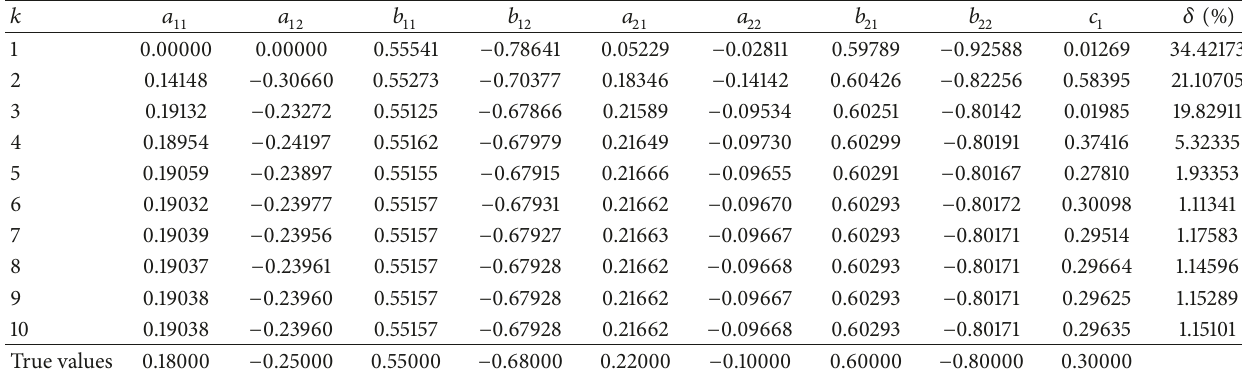
Table 3: The H-LSI parameter estimates and errors for Example 2.